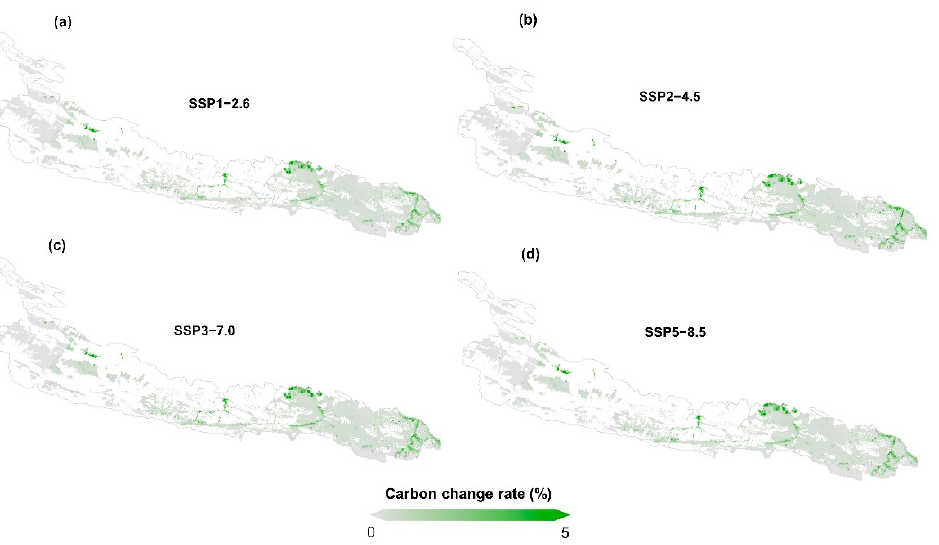
Figure 5. The distribution of the change rate of the carbon sink capacity with and without manage- ment in 2060 under climate change scenarios SSP1-2.6 ( a ); SSP2-4.5 ( b ); SSP3-7.0 ( c ) and SSP5-8.5 ( d